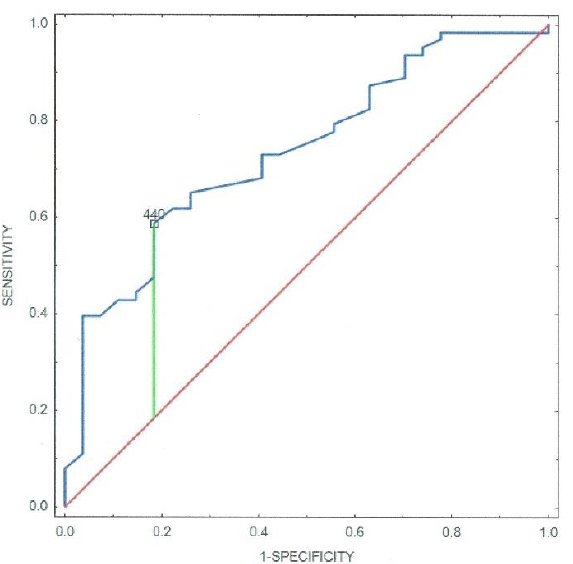
Figure 6. ROC curve of the QTc on admission for the ejection fraction measured during the first 48 h since admission. The AUC was 0.735 (standard error = 0.055, 95% confidence interval: